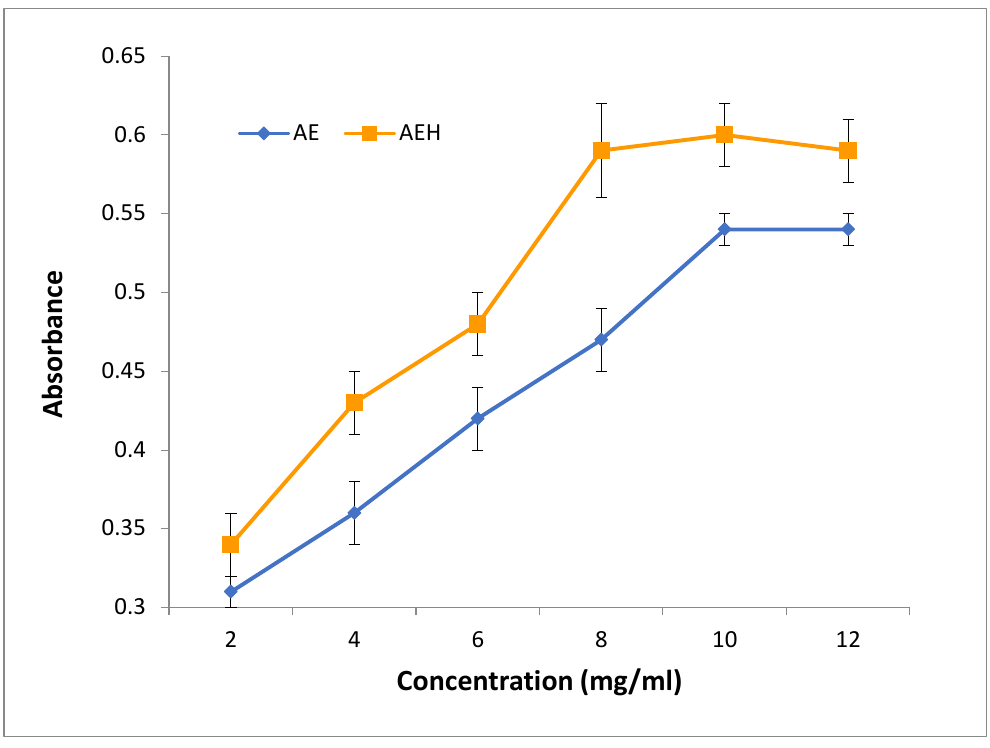
Figure 2. Ferric reducing antioxidant power of MF extracts. AE = Aqueous extract; AEH = Aqueous ethanolic